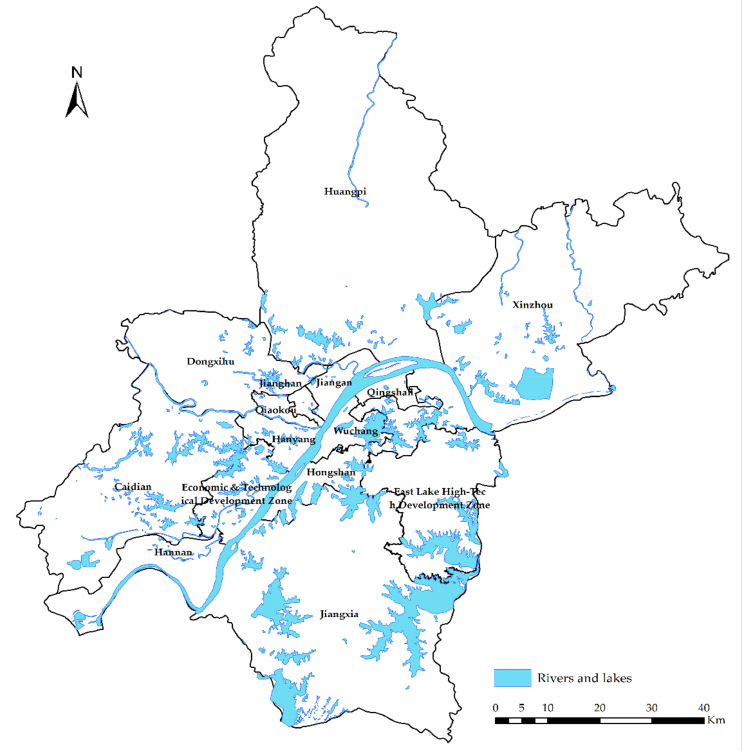
Figure 1. Map of the administrative divisions of Wuhan